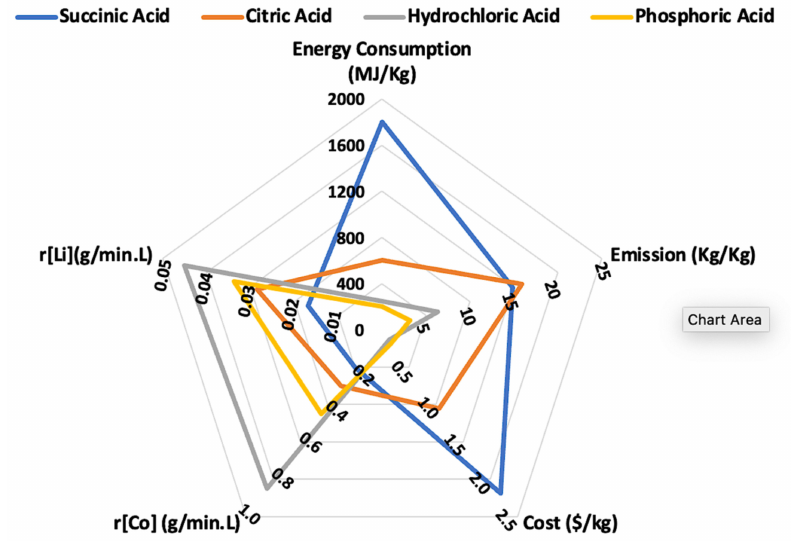
Figure 12. Spider chart for a relative evaluation index of leaching spent Li-ion batteries with various conventional leaching reagents (Data derived from refs.